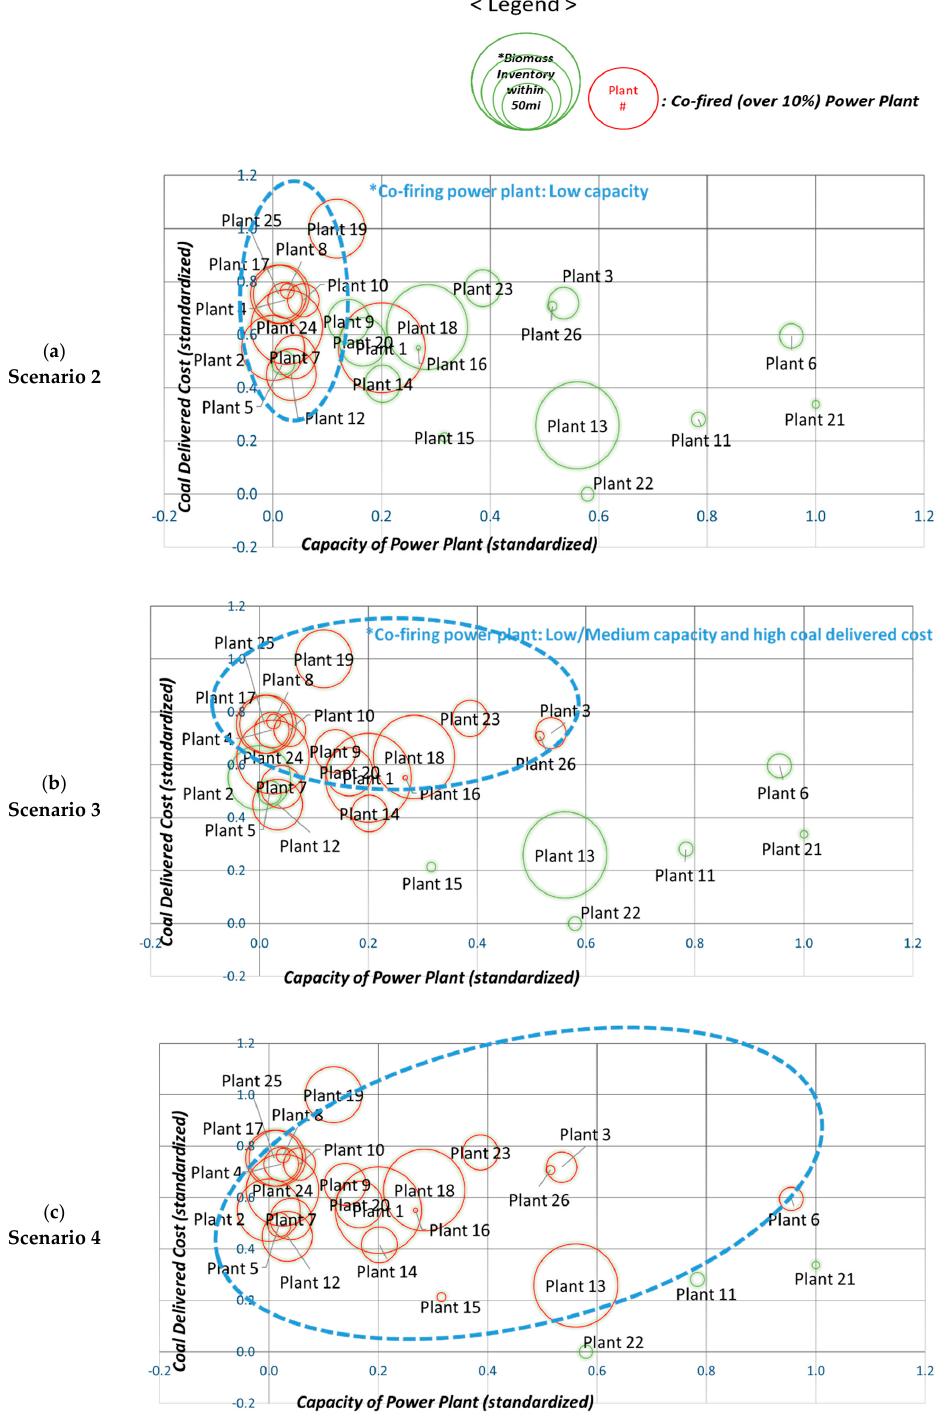
Figure 8. Relationship between logistics conditions and co-firing ratio by scenario. ( a ) Scenario 2: Conventional Logistics + PTC; ( b ) Scenario 3: Advanced Logistics + No PTC; ( c ) Scenario 4: Advanced Logistics + PTC.